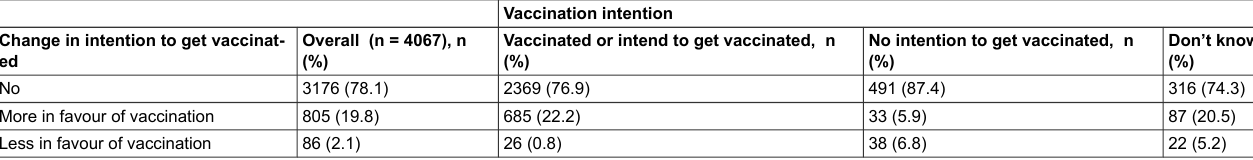
Table 3: Reasons for change in vaccination intention in the past 3 months. Reasons for change in intention Change in the pandemic